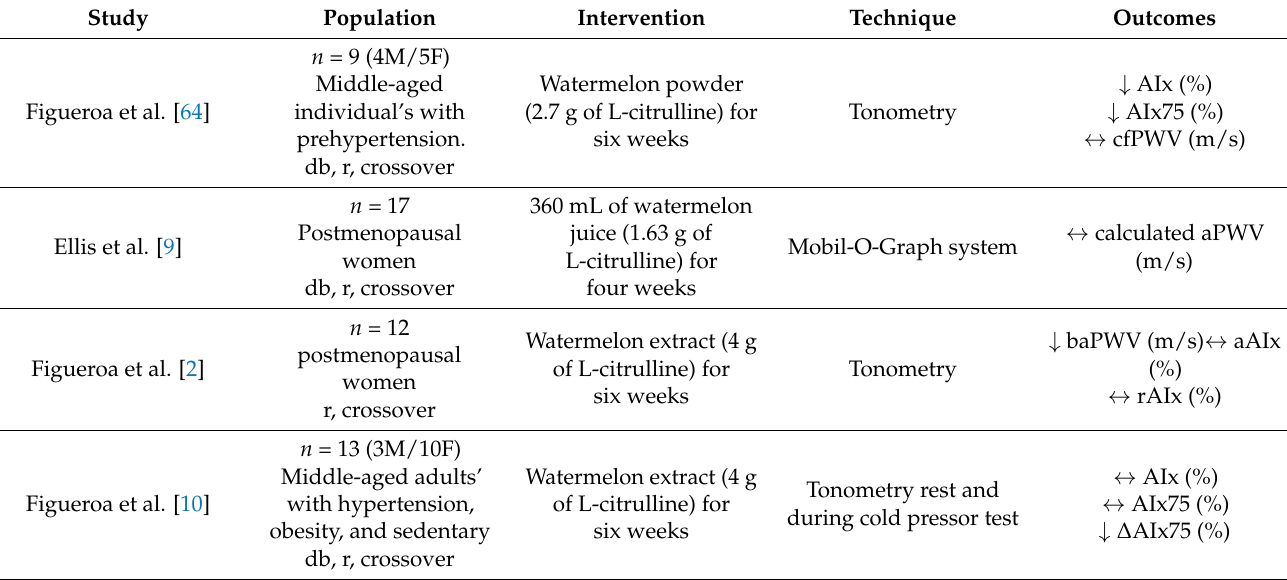
Table 2. Summary of the studies that evaluated the effect of watermelon ingestion on arterial stiffness and pressure wave